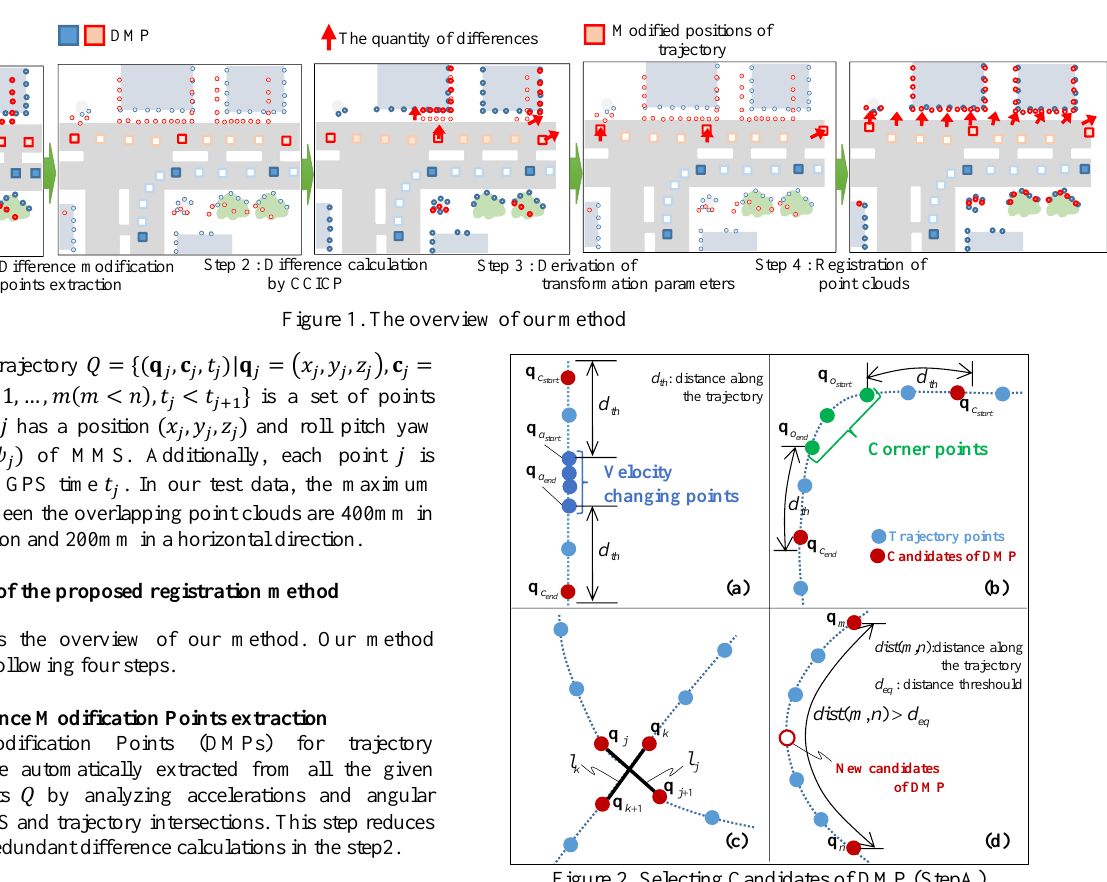
algorithm. The CCICP algorithm is a new variant of ICP algorithm for MMS point clouds which minimizes point-to-